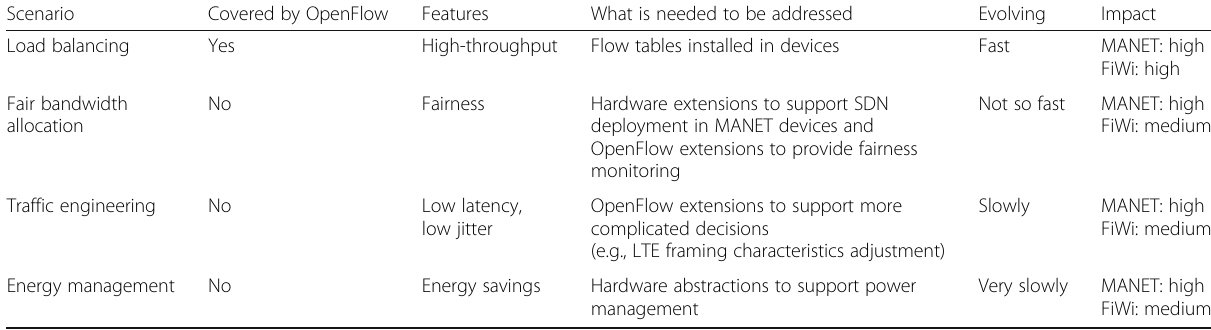
Table 2 Open implementation issues for federated FiWi-MANET deployments Scenario